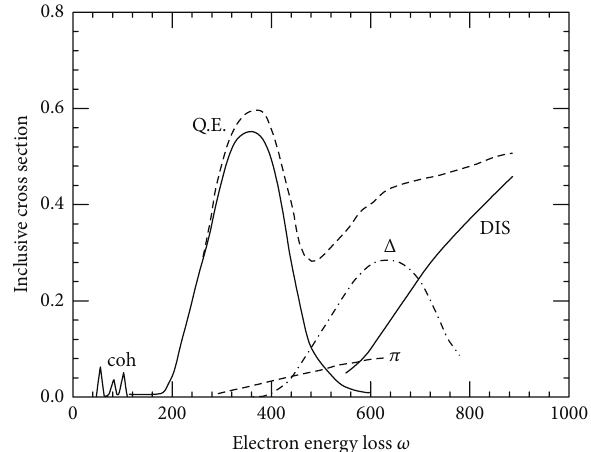
Figure1:Schematicrepresentationoftheinclusiveelectron-nucleus cross-section at beam energy around 1GeV, as a function of energy